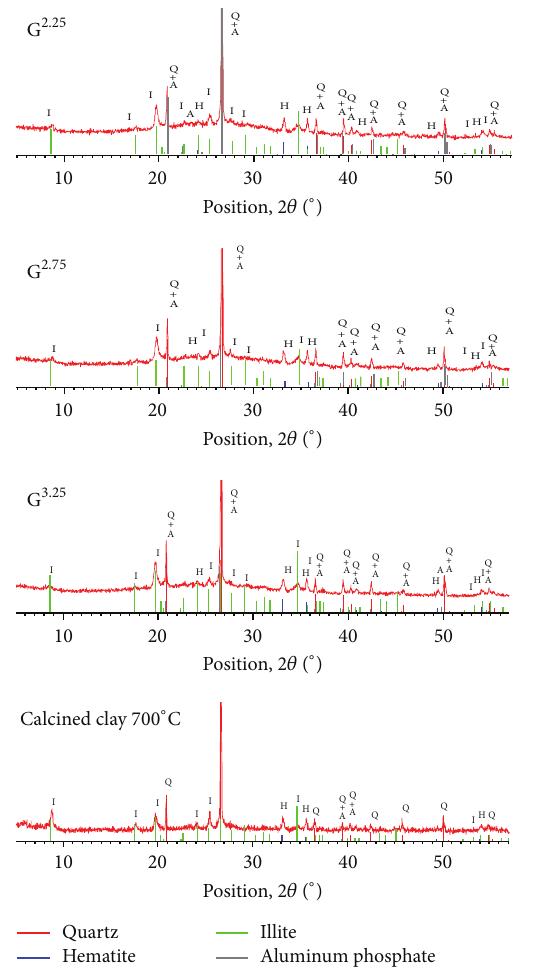
Figure 3: X-ray patterns of calcined clay and the obtained geopoly- mers G 𝑥 with different Si/P molar ratios (21 curing ages). Q: quartz (00-046-1045), H: hematite (00-024-0072), I: illite (00-024-0495), and A: aluminum phosphate (00-084-0853).